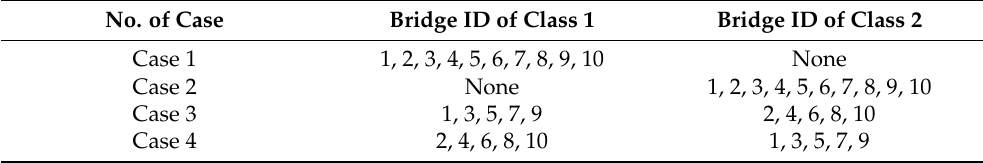
Table 3. Classification of bridges in different network